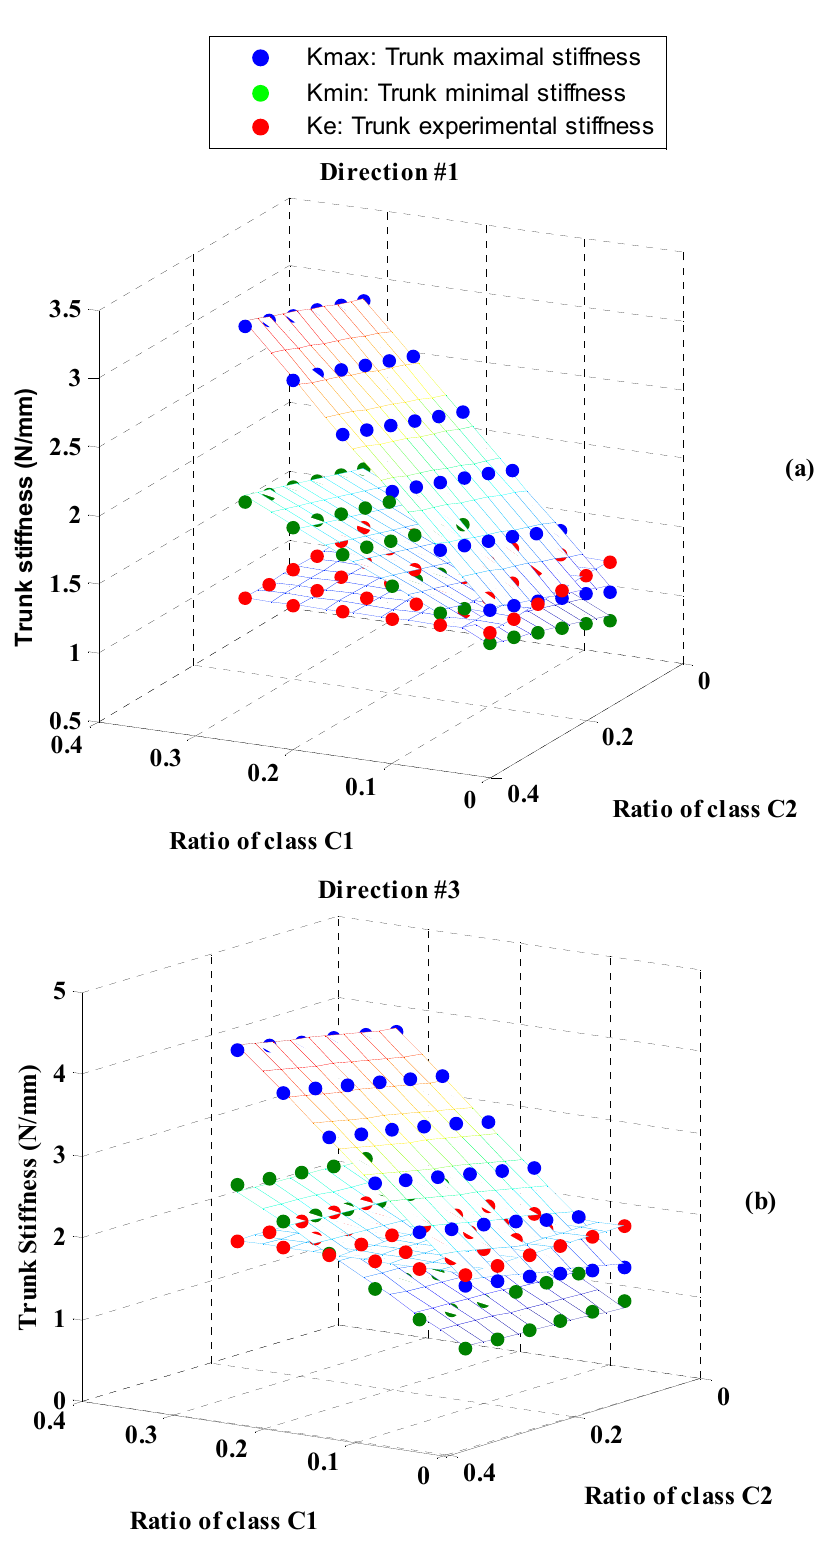
Figure 4. Experimental, minimal, and maximal trunk stiffness as functions of the tone ratios for classes C1 and C2 and directions 1 ( a ) and 3 ( b ), respectively. The class C3 tone ratio ( β 3 ) is set to 15%.